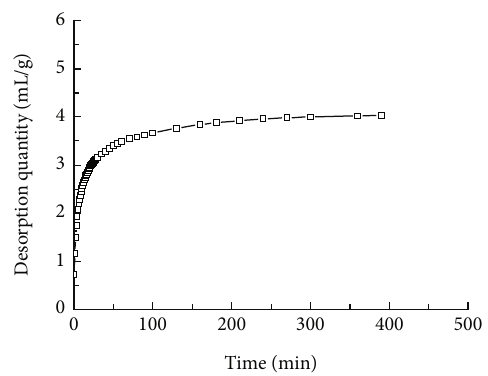
Figure 4: Gas desorption quantity from nonwater-injected coal sample (including the gas in the